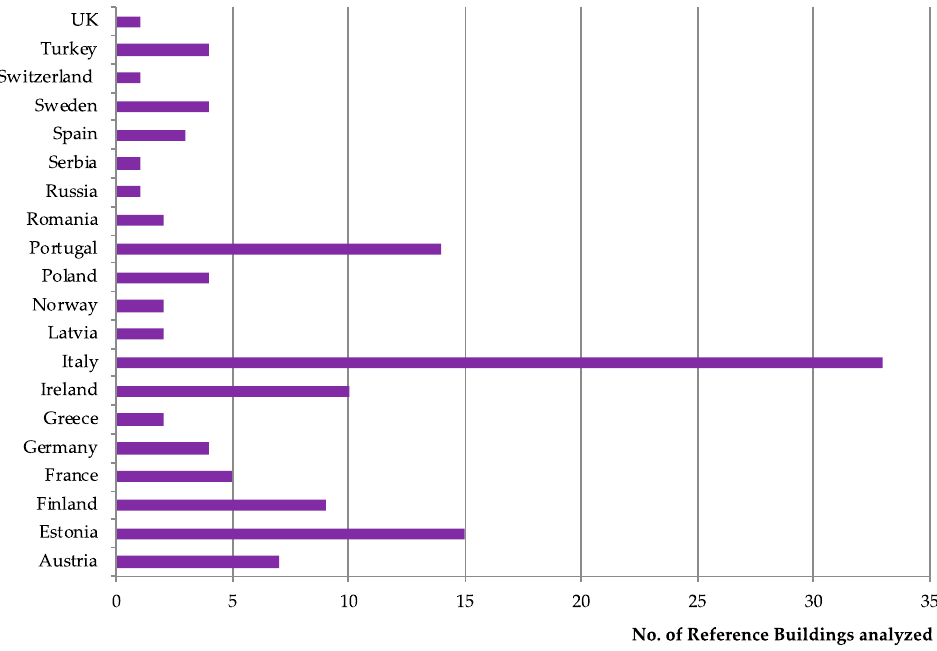
Figure 5. Reference buildings in cost-optimal studies by countries.